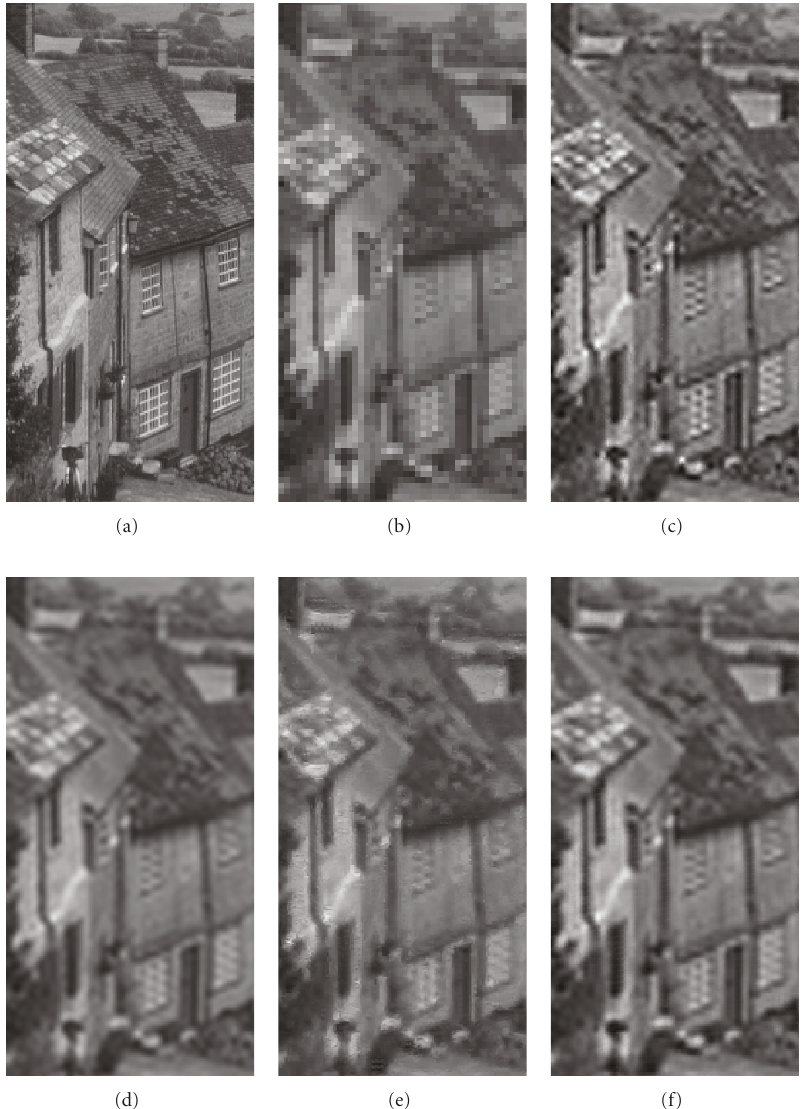
Figure 6: Zoomed portions of the results in Figure 5: (a) zoomed portion of Figure 5(a), (b) zoomed portion of Figure 5(b), (c) zoomed portion of Figure 5(c), (d) zoomed portion of Figure 5(d), (e) zoomed portion of Figure 5(e), and (f) zoomed portion of Figure